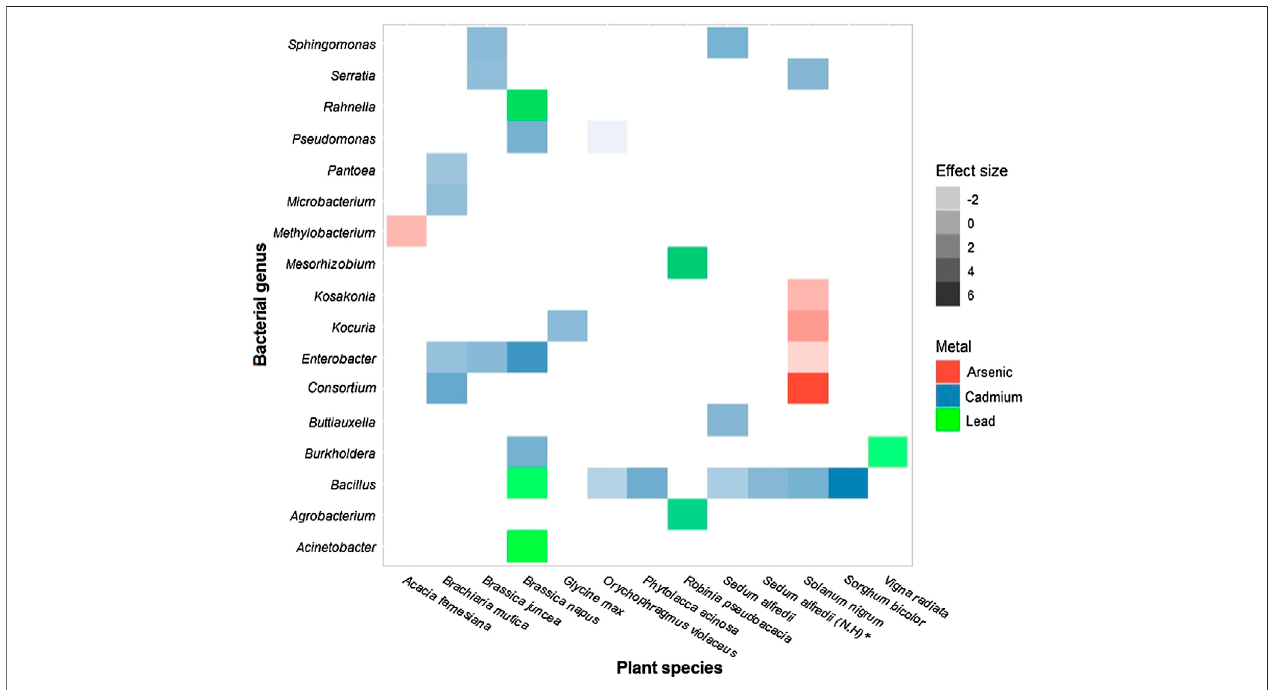
FIGURE 6 | Size of the effect of the bacterial genus on plant species under stress from the three most toxic metals: Cadmium ( ), Arsenic ( ) and Lead ( ). A totalof35combinationsof17bacteriagenreand13hostplantswereobtained.Thegrayscaleindicatestheleveloftransparencyofthedifferentcombinationsaccording to the value of the effect size. * Sedum alfredii (N.H) is a non-accumulator